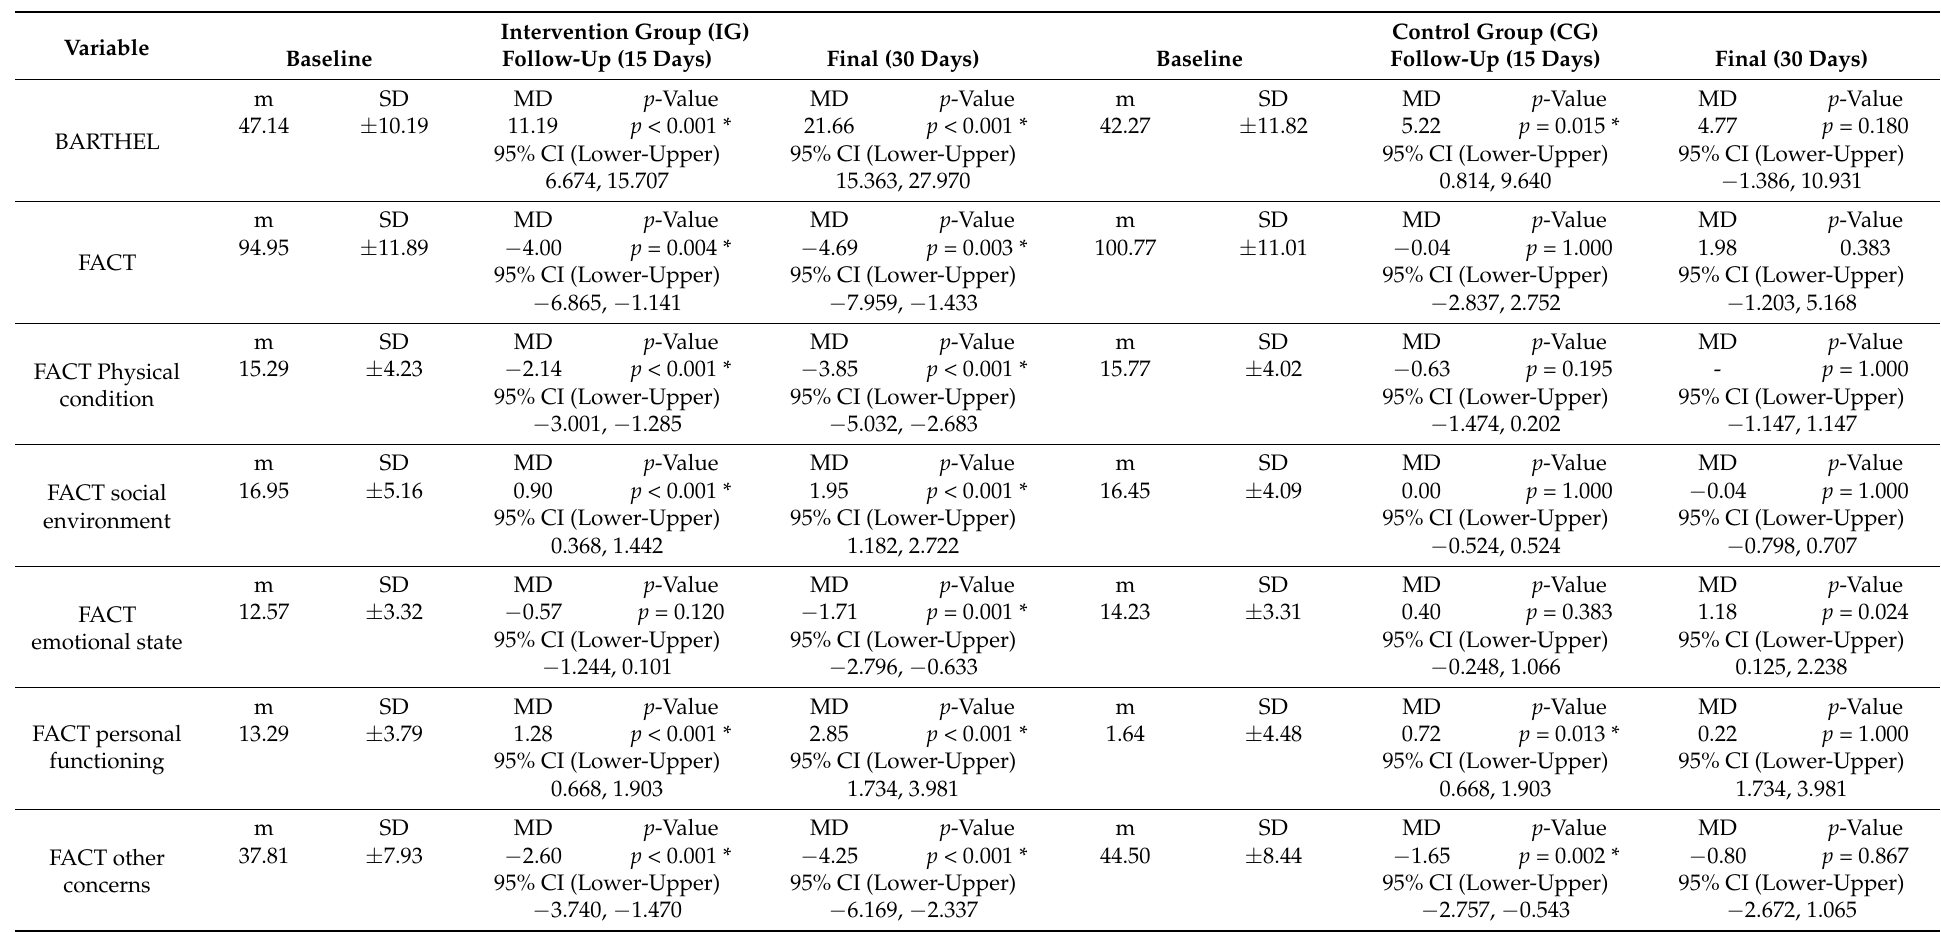
Table 3. Analytical statistics of the different variables under study. Baseline, follow-up, and final assessment in both groups (experimental and control) (two-way repeated measures